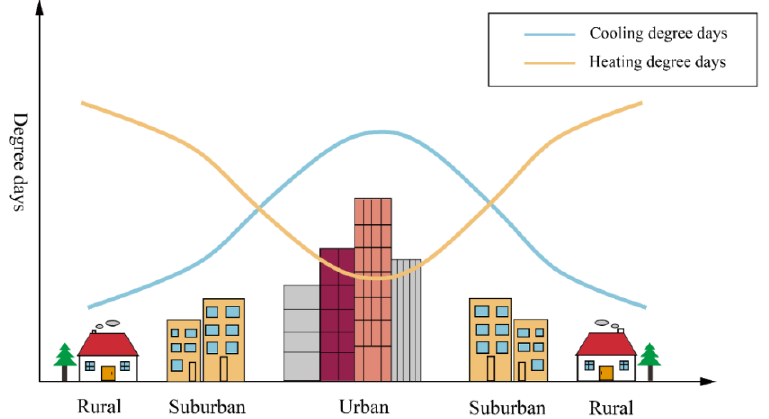
Figure 3. Schematic diagram of the impacts of urbanization on heating and cooling degree days.